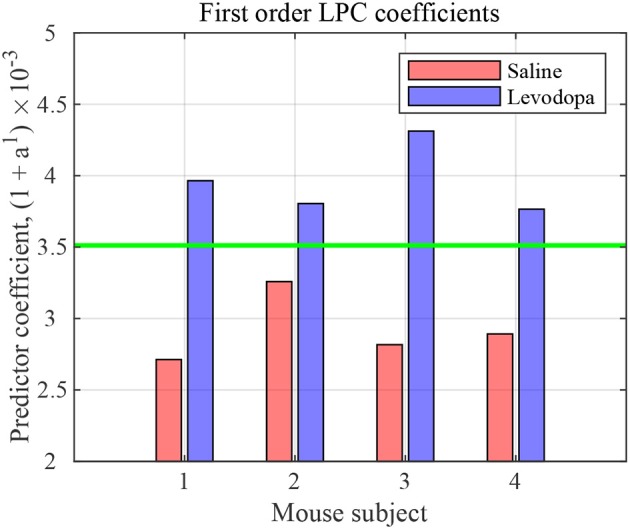
First order LPC coefficients for striatal LFPs in saline-injected (red) and levodopa-injected (blue) dopamine-depleted mice. These coefficients are sufficient for binary classification of the LFP data for mice 1–4. The threshold (green) is calculated by taking the average of the minimum value in levodopa session and the maximum value in saline session.